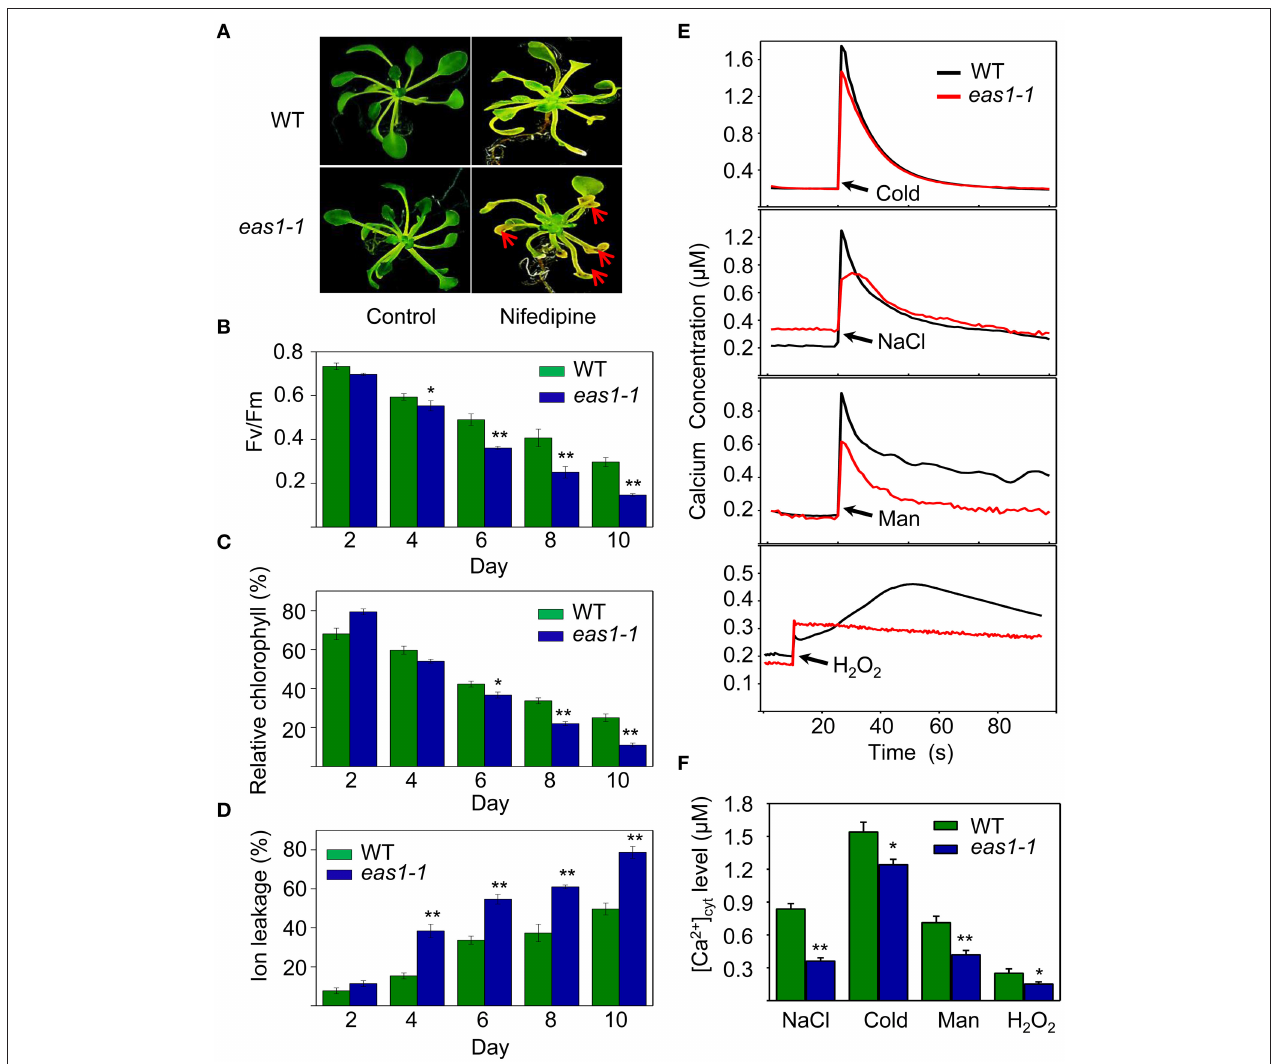
FIGURE 7 | Calcium deficiency accelerates leaf senescence of eas1-1 mutant plants and analysis of kinetic changes in [Ca 2 + ] cyt in response to several stresses in wild-type and eas1-1 mutant seedlings. (A) Seedlings grown on MS medium for 5 days were then moved to MS medium supplemented with 200 µ M nifedipine for 8 days. Clear aging symptoms are shown by red arrows. (B) Time-dependent Fv/Fm values of wild-type and eas1-1 mutant seedlings on medium supplemented with 200 µ M nifedipine. (C,D) Relative chlorophyll contents and ion leakage at different times in wild-type and eas1-1 leaves on medium supplemented with 200 µ M nifedipine. (E) Elevation of [Ca 2 + ] cyt measured by Aq-emitted luminescence in response to cold shock (4 ◦ C), 400mM NaCl, 500mM mannitol, and 10mM H 2 O 2 in 7-days-old wild-type and eas1-1 mutant seedlings. (F) Increased Ca 2 + concentrations evoked by cold shock (4 ◦ C), 400mM NaCl, 500mM mannitol, and 10mM H 2 O 2 in 7-days-old wild-type and eas1-1 mutant seedlings. Bars indicate standard errors, while asterisks indicate significant differences from wild-type plants under Student’s test ( * p < 0.05 , ** p < 0.01 ); three experiments were performed with similar